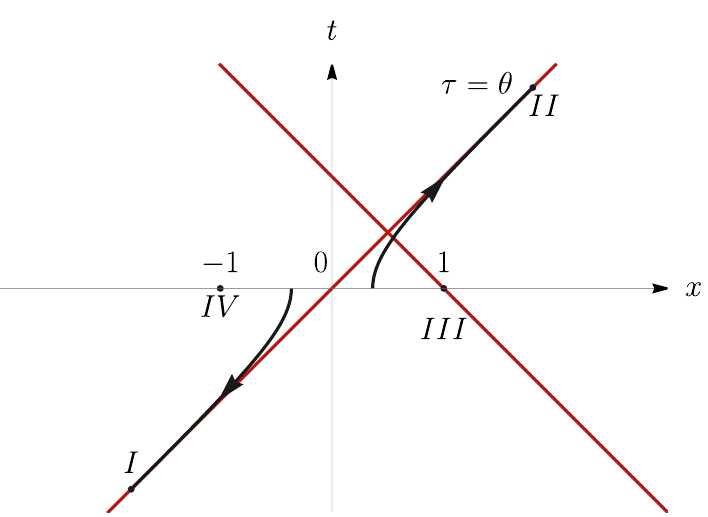
Figure 15 . The image of the part of the path of subsection 2.4 that has a map in the ρ , ¯ ρ plane. The right black curve depicts the insertion position of opertor II. The trajectory is one of decreasing τ ; it starts at τ = π and ends at τ = θ